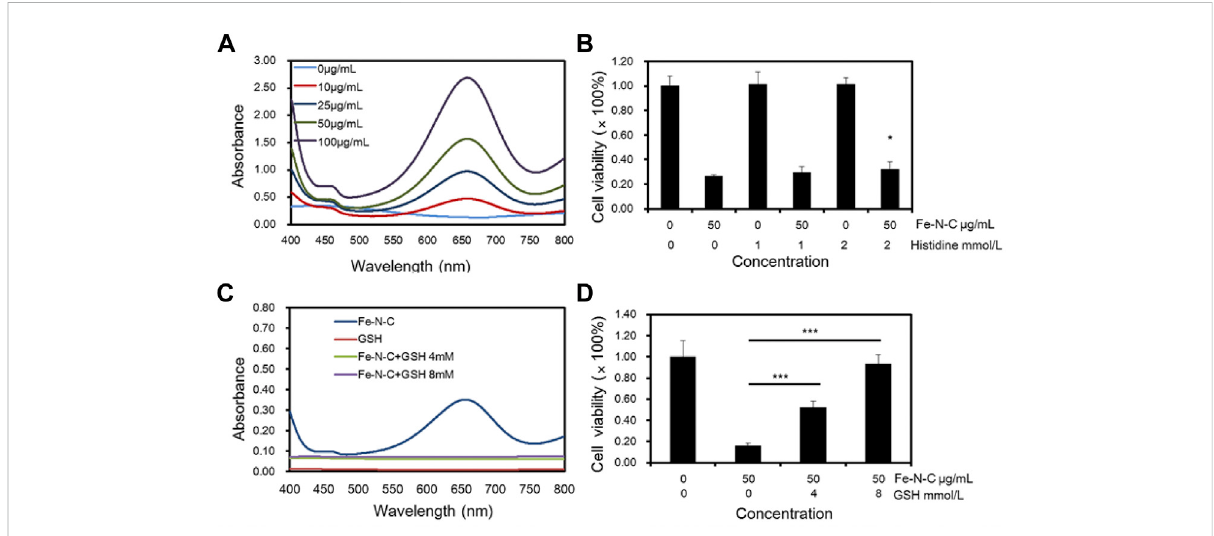
FIGURE 6 (cid:129) OHgeneration. (A) IntracellularH 2 O 2 detectionthroughcolorimetricassayofTMBassubstrate(within10 min) Fe-N-CCDTactivitycausedby byUV-Vis-NIRabsorptionspectraat652 nmwithdifferentFe-N-CconcentrationinMDA-MB-231cells. (B) MDA-MB-231cellsviabilitywasdetected by CCK-8 assay, that cells were treated with histidine following by 50 μ g/ml Fe-N-C for 4 h. (C) Intracellular H 2 O 2 detection by UV-Vis-NIR absorption spectra with or without GSH addition. Each group contained 1 × 10 5 MDA-MB-231 cells and Fe-N-C 25 μ g/ml. (D) Cell viability of MDA-MB-231 cells treated with GSH following by Fe-N-C with 50 μ g/ml for 4 h. Data are representative of three (A,D) or four (B,C) independent experiments. Summary data are shown as the mean ± S.E.M. with p values determined by two-tailed Student ’ s t-test (* p < 0.05, ** p < 0.01, *** p <